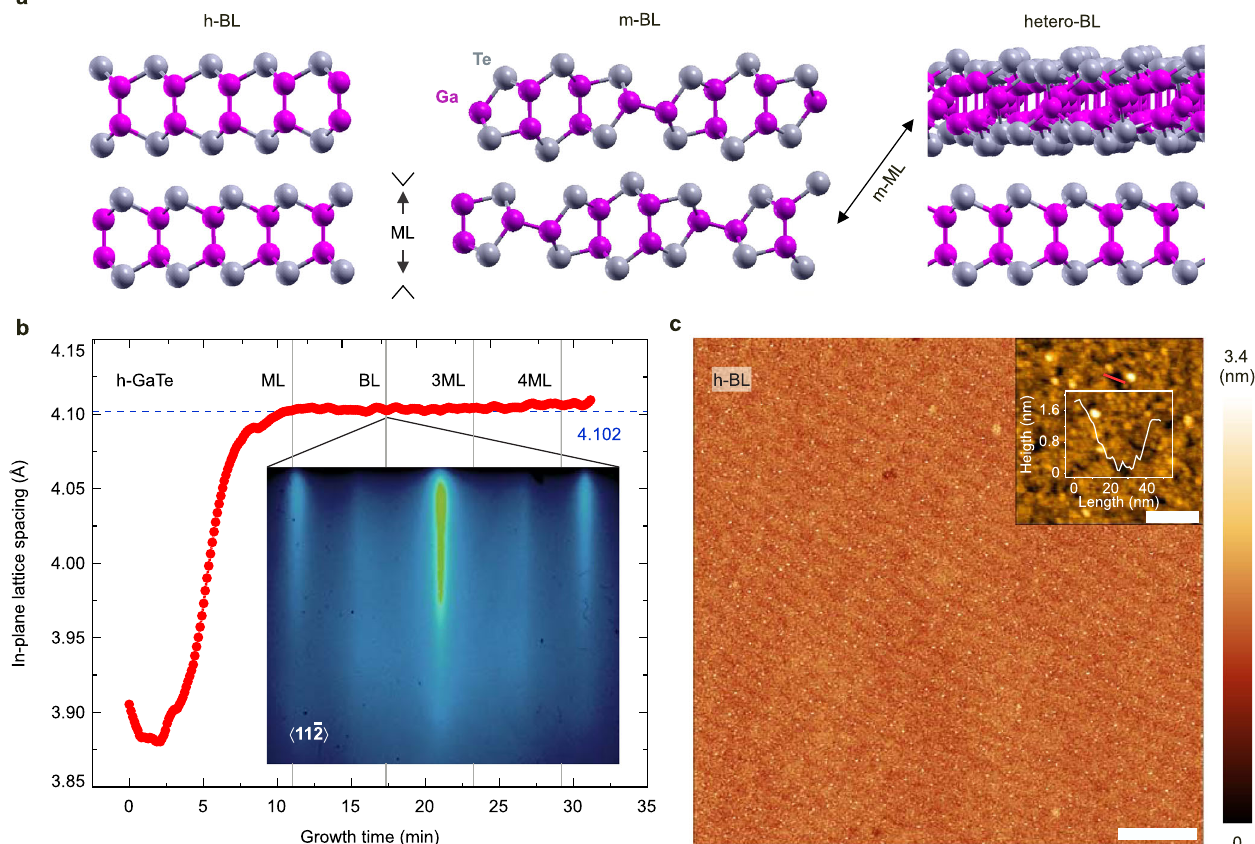
Fig. 1 Van der Waals epitaxy of h-GaTe on Sb passivated Si(111). a Supercell bilayers (BLs) GaTe in the hexagonal phase with β stacking (h- GaTe) and monoclinic phase (m-GaTe), and vertical heterostructure by combining monolayers (MLs) of the two phases together (hetero-BL). b In-plane lattice spacing evolution as a function of time during the MBE growth. The lattice parameter is calculated from the streak distance in the in-situ RHEED patterns acquired perpendicular to the Si h 112 i direction. The layer thickness dependency is obtained from the specular spot RHEED oscillations (see Supplementary Fig. 1). The inset shows the RHEED pattern from BL h-GaTe. c AFM height image of the BL h-GaTe measured after taking it out of the MBE chamber without capping layer. Scale bar is 2 μ m. The zoomed in AFM in the inset (scale bar is 100 nm) shows the pro fi le highlighted in red of a discontinuity region in the GaTe